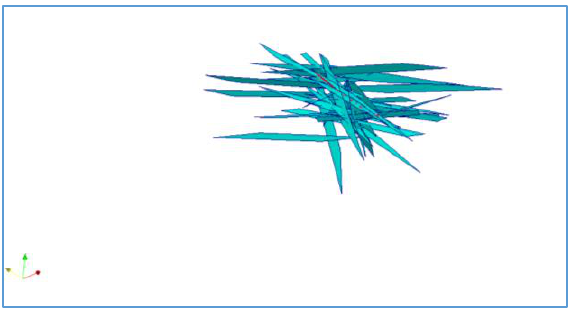
Energies 2020 , 01 , x FOR PEER REVIEW Figure 34. Shortest fracture paths to the water contact for well B1. Figure 34. Shortest fracture paths to the water contact for well B1.